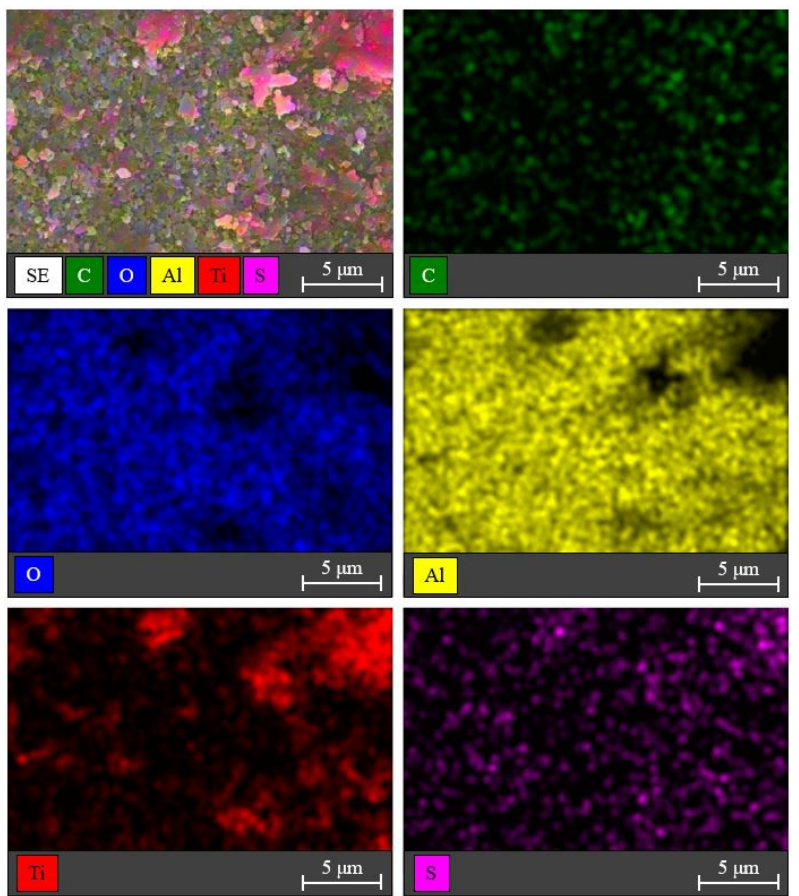
Figure 10. SEM photos and EDS mapping analysis (C, O, Al, Ti, and S elements) for the S,N-doped TiO 2 /Al 2 O 3 HF membrane surface.